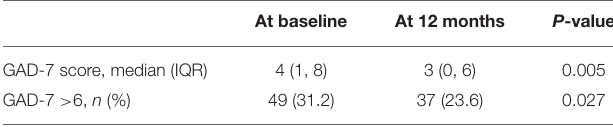
after a diagnosis of epilepsy ( n = 157). At